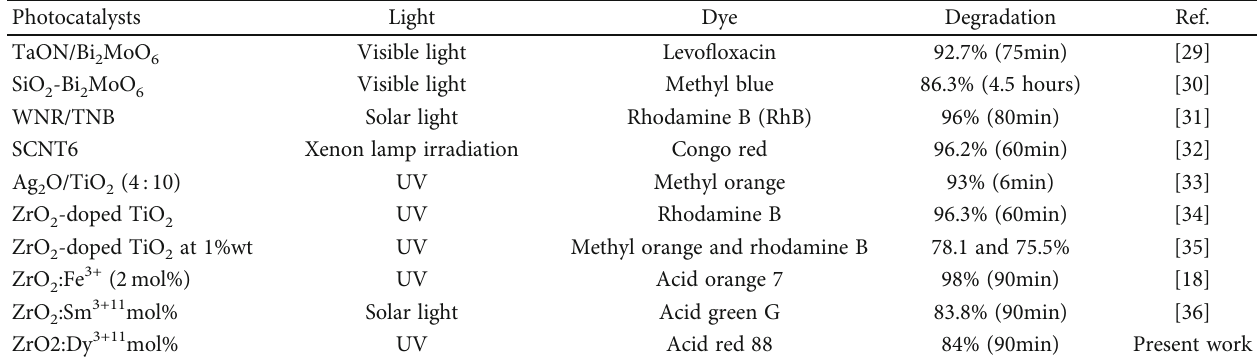
Figure 9: Half-life plot for the AR88 dye under UV irradiation in the presence of ZrO Table 3: Summary of the photocatalytic degradation of various photocatalysts and dyes. Photocatalysts Light Dye Degradation